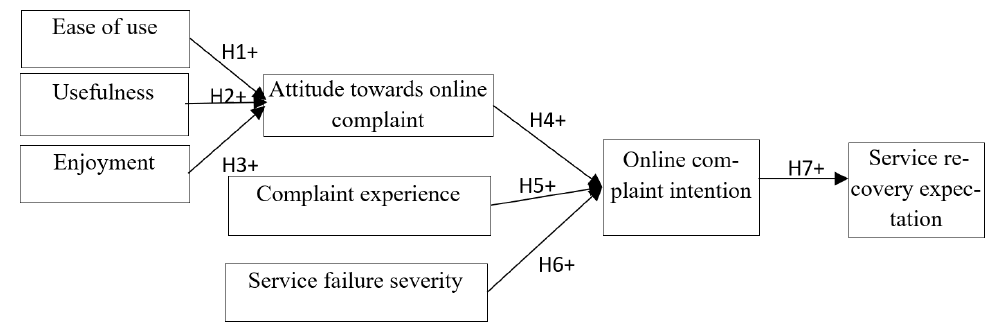
Fig.1 . Proposed research model